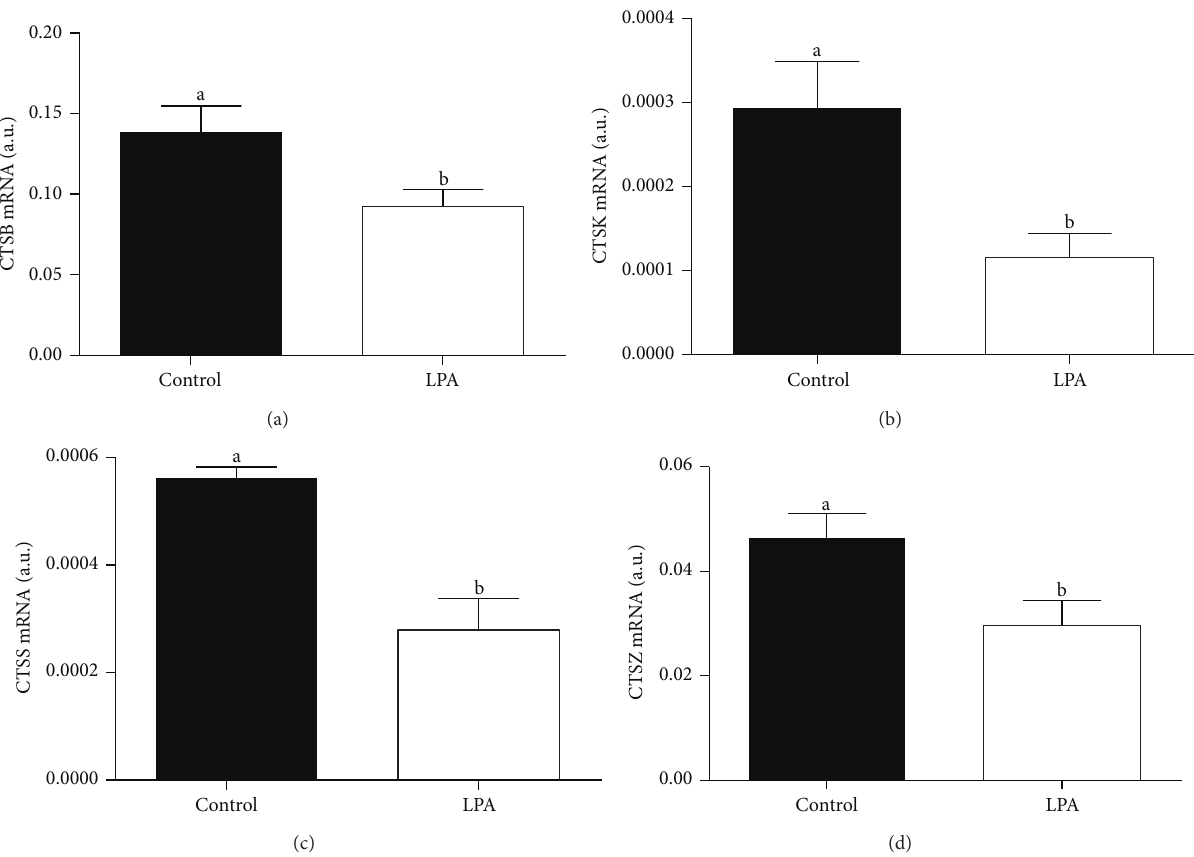
Figure 4: The effect of LPA (10 −5 M) supplementation of maturation medium on mRNA abundance of CTSB (a), CTSK (b), CTSS (c), and CTSZ (d) in cumulus cells. The values are expressed as mean ± SEM. Different letters indicate significant differences ( 𝑃 < 0.05 ), as determined by Student’s 𝑡